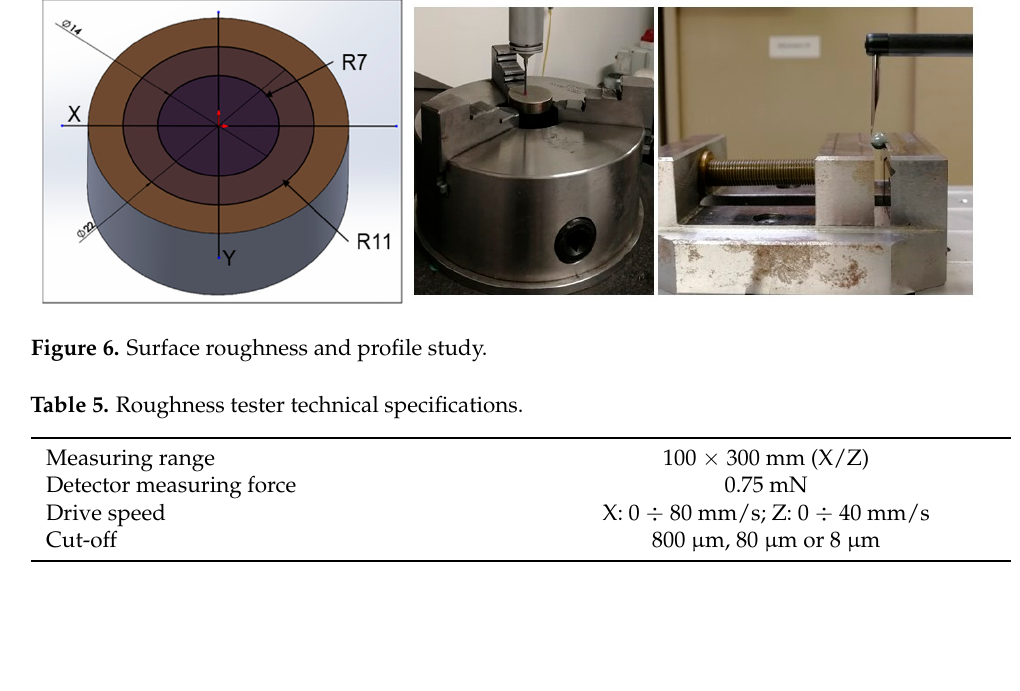
Table 6. Profilometer technical specifications.